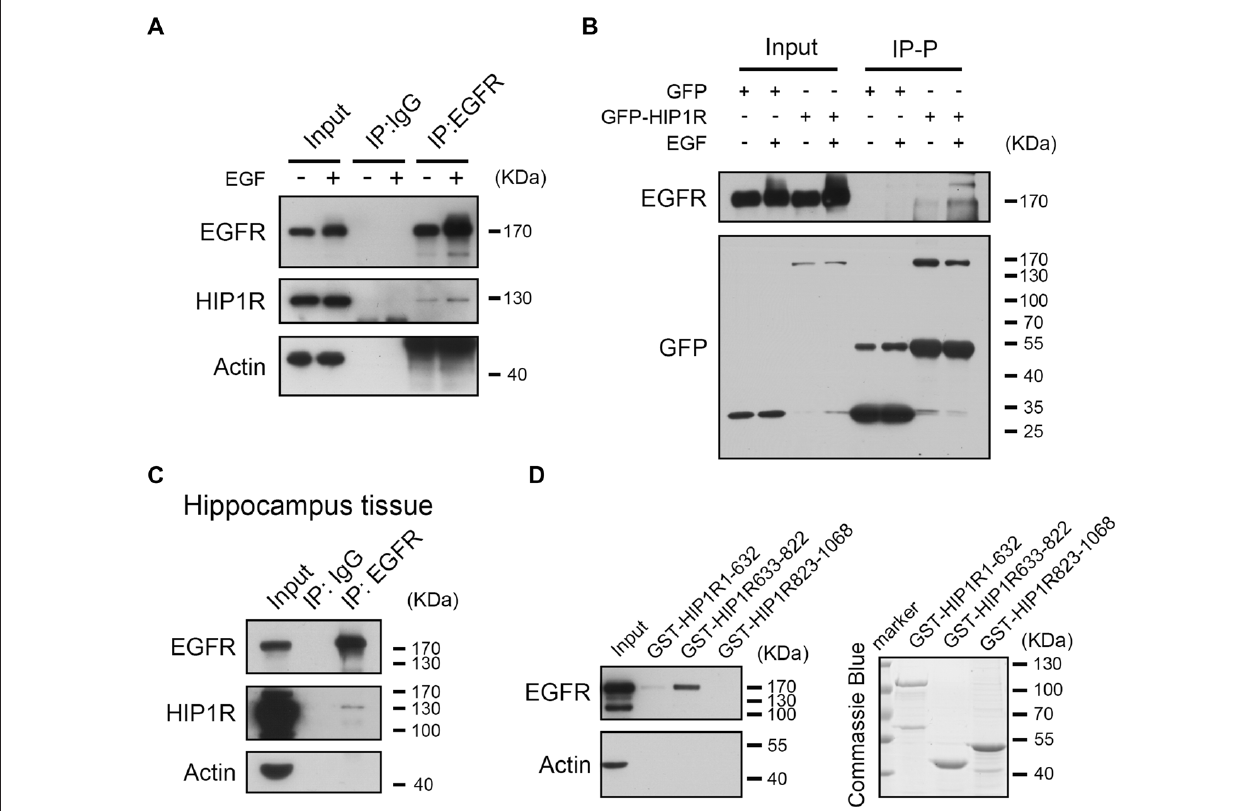
FIGURE 7 | HIP1R interacts with EGFR via amino acid 633–822 fragment. (A,B) EGFR interacts with HIP1R in cultured hippocampal neurons harvested at DIV 6–8. (A) Neuron lysates were immunoprecipitated with an anti-EGFR antibody. Lysates (input) and precipitates (Immunoprecipitation, IP: IgG and IP: EGFR) were blotted with anti-EGFR, anti-HIP1R and anti-actin antibodies. (B) Neurons electroporated with GFP-HIP1R or GFP-control were immunoprecipitated with anti-GFP antibody. (C) EGFR interacts with HIP1R in hippocampus tissue dissected from 6-week-old male mice. (D) GST-pull down of EGFR using purified GST-HIP1R 1–632 , GST-HIP1R 633–822 and GST-HIP1R 823–1068 in cultured hippocampal neurons harvested at DIV